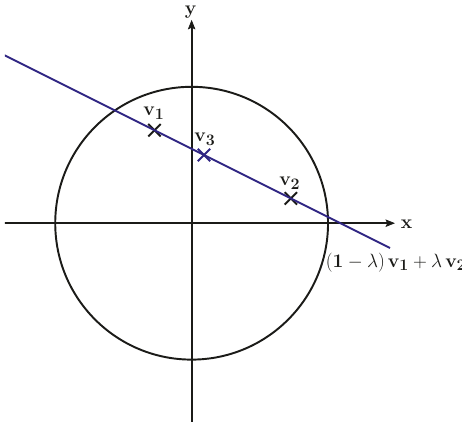
Figure 2 . A graphical representation of the two-point splitting lemma. The two-dimensional ( xy ) plane is spanned by two arbitrary linearly independent vectors v 1 and v 2 . The head of the third vector v 3 (we show one typical example) lies in the straight line connecting the heads of v 1 and v 2 . The circle represents all vectors with v · v = 1